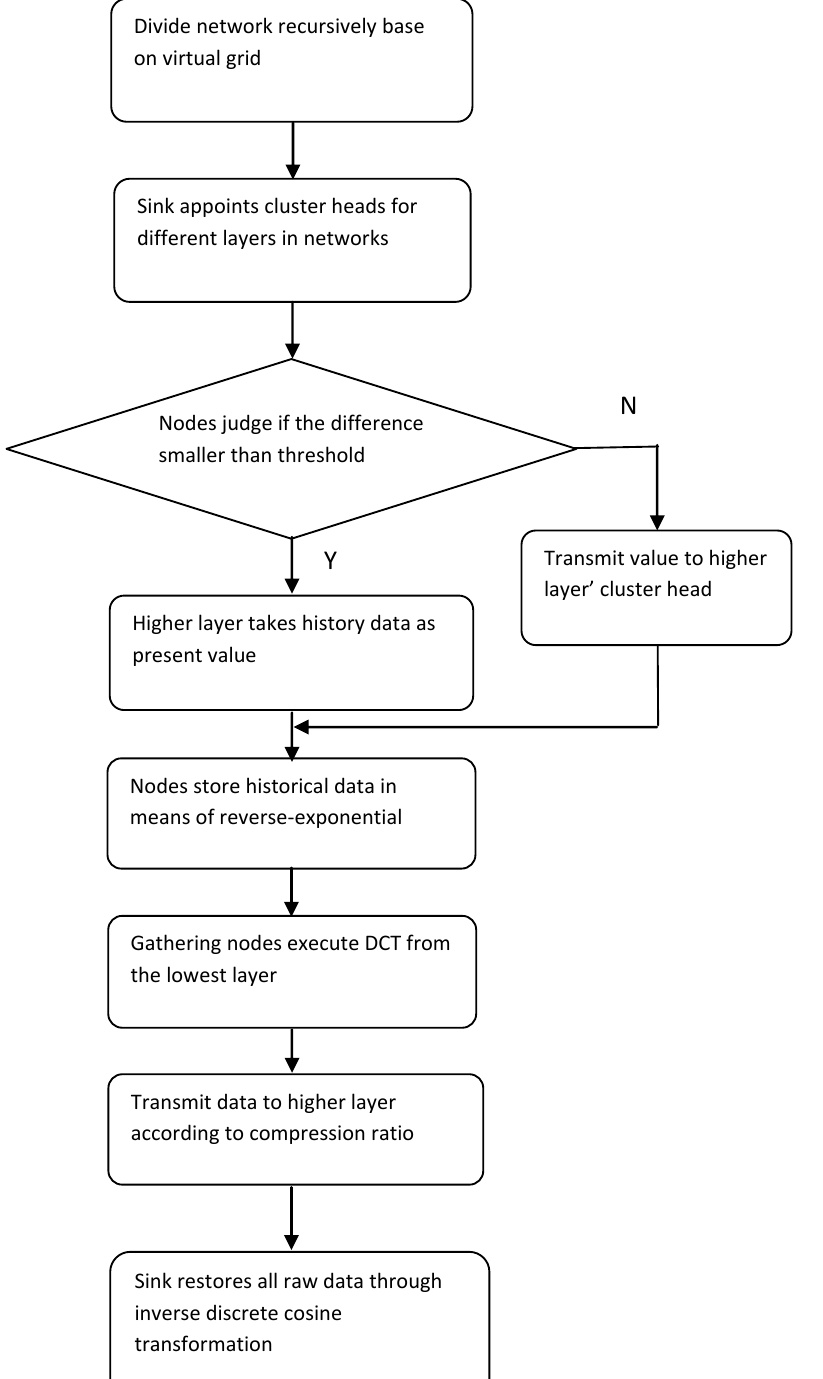
Figure 2. Flow chart of the MSTC